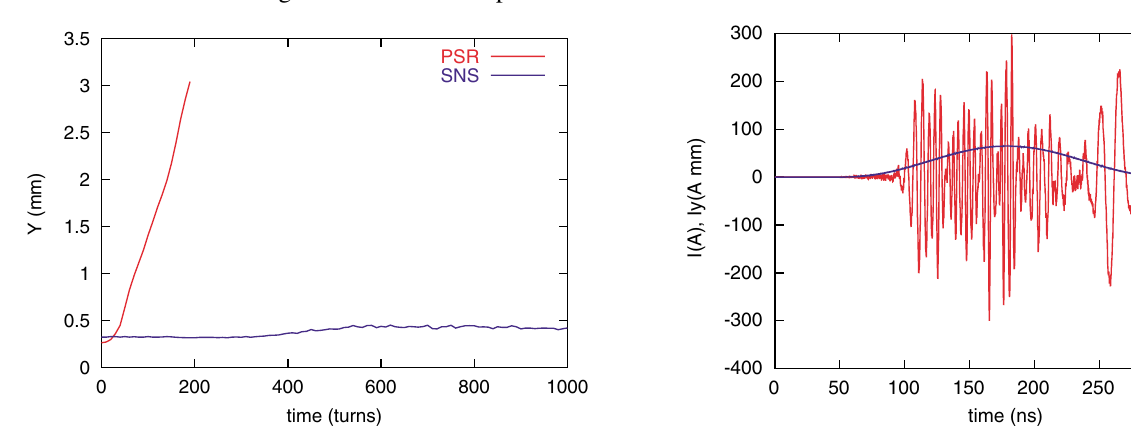
Fig. 23. The dipole density corresponds to the Y (cid:6)